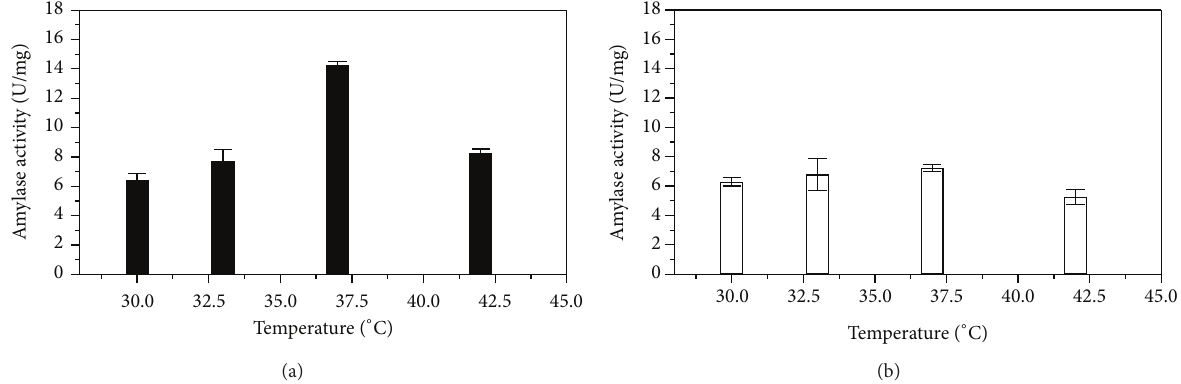
Figure 3: Effect of temperature on 𝛼 -amylase yield after various periods of fermentation using B. amyloliquefaciens (MTCC 1270); white column: specific activity of 𝛼 -amylase from 24 hours SSF extract; black column: specific activity of 𝛼 -amylase from 48 hours SSF extract.